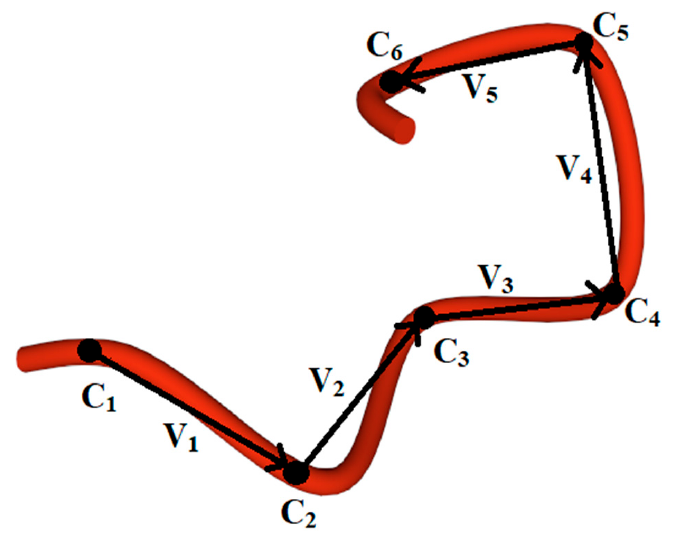
Figure 5. Graphic construction of v i vectors for calculating the mixed vector product, Ω -loop of the 2ACT protein [100] (residues 8–13). C i –atoms of α -carbons, reference points in the Ω Figure 5. Graphic construction of 𝐯 (cid:3036) vectors for calculating the mixed vector product, Ω -loop of the 2ACT protein [100] (residues 8–13). С (cid:3036) –atoms of α -carbons, reference points in the Ω -loop.